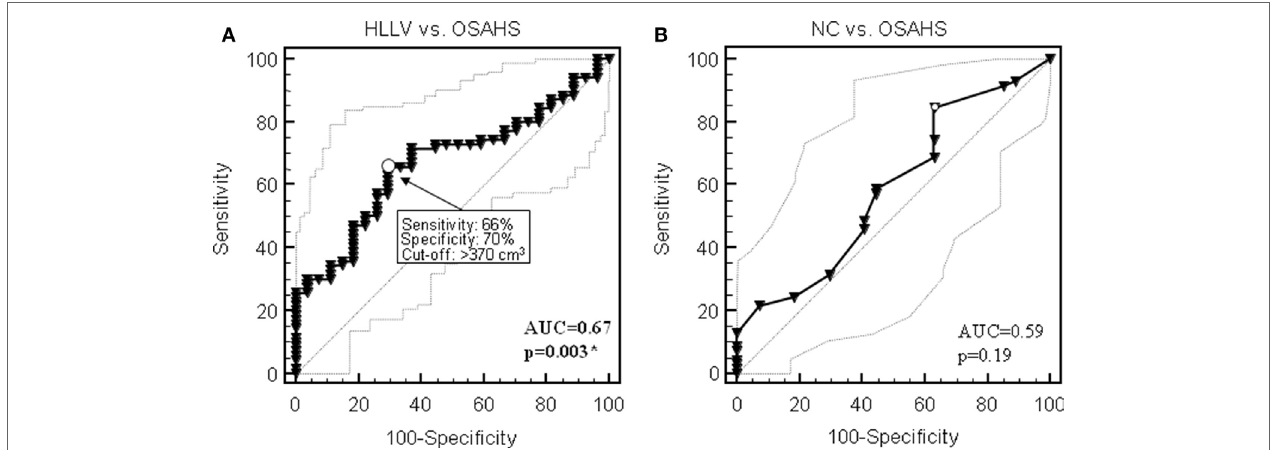
FigUre 4 | Receiver operating characteristic (ROC) curves for the diagnostic performance of hepatic left lobe volume (HLLV) (a) and neck circumference (NC) (b) to identify obstructive sleep apnea syndrome (OSAHS) in the cohort of 97 obese patients. Thin lines show 95% confidence intervals; arrows point at the optimal cutoff as defined by the Younden index for diagnostic sensitivity and specificity. AUC, area under the curve. * p < 0.05 by ROC curve